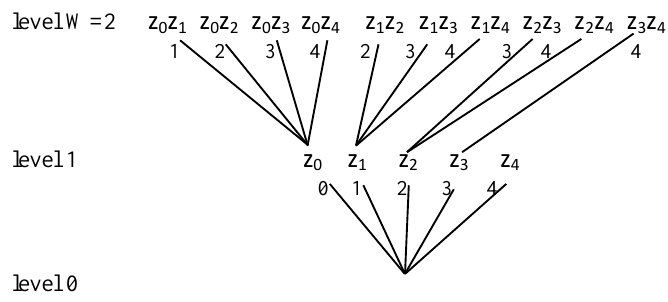
Figure 7. A bottom-up tree structure for feature selection Figure 7. A bottom up tree structure for feature selection [24].